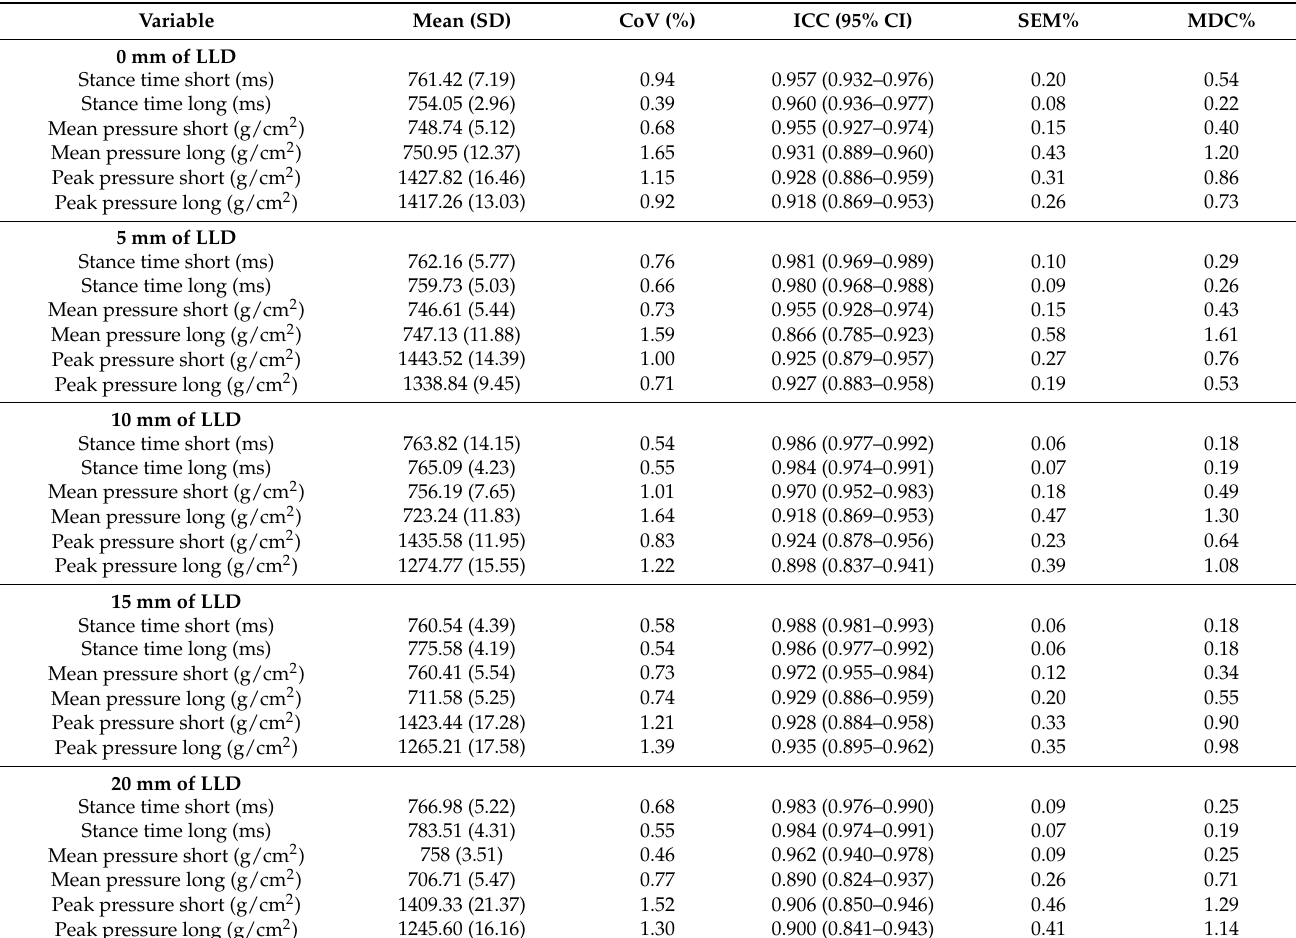
The average measurements from both test sessions and intersession reliability data, represented by CoV, ICC, SEM% and MDC%, are presented in Table 3. The CoV for intersession reliability ranged from 0.39% to 1.65%, and the ICC ranged from 0.866 to 0.988. The SEM% ranged from 0.06% to 0.58% and MDC% ranged from 0.18% to 1.61%. Table 3. Intersession reliability of time and pressure variables for each foot under simulated LLD conditions.